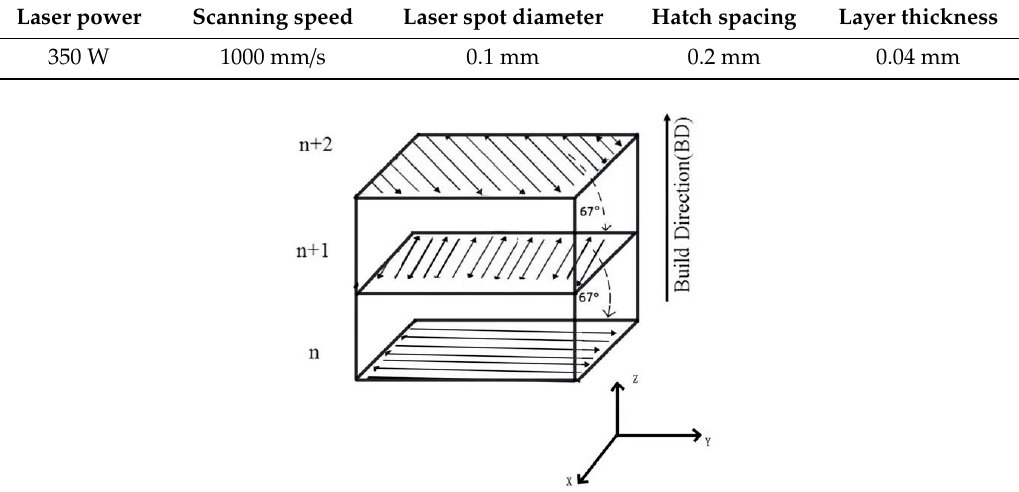
Table 2. Selective laser melting (SLM) manufacturing parameters.